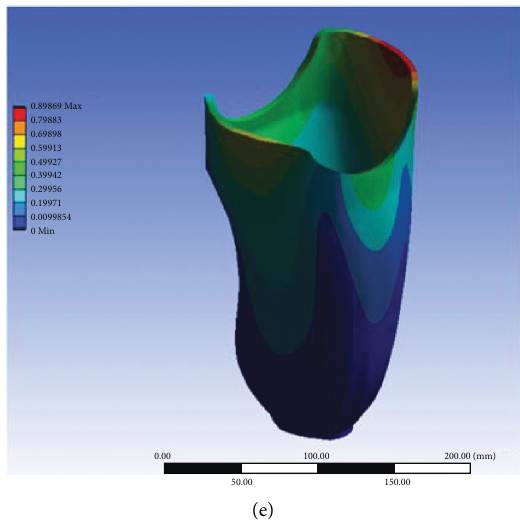
Figure 8: Contours of total deformation distribution of (a) pristine biobased epoxy, (b) FF/biobased epoxy composite, (c) FF/1wt % SS/ biobased epoxy composite, (d) FF/3wt % SS/biobased epoxy composite, and (e) FF/5wt % SS/biobased epoxy composite.